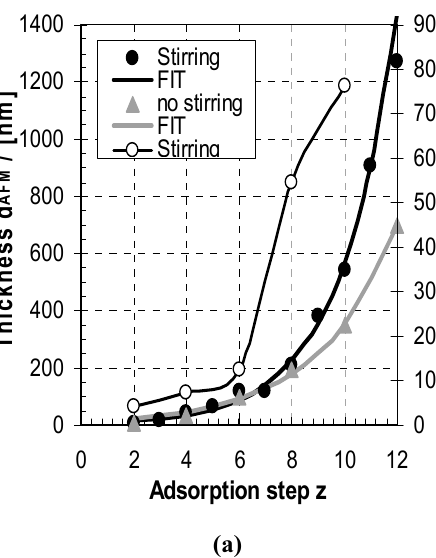
Figure 3. ( a ) Thickness (left y -axis) and roughness (right y -axis) of the PEMs of PEI / PAA in relation to z obtained by dipping method and drying after each rinsing step with stirring (black circles) and without stirring (grey triangles). Roughness values (RMS) are included for the stirring case (open circles). ( b ) Mass per area m / a (black cubes, left y -axis) and IR band integral (transmission mode, open circles, right y -axis) of the PEMs of PEI / PAA in relation to z obtained by the dipping method with stirring and drying after each rinsing step.